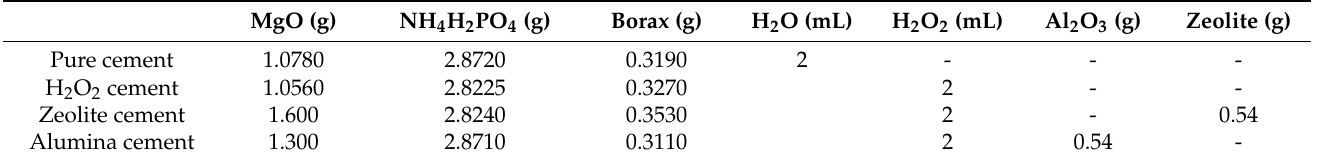
Table 1. Chemical compositions of synthesized samples.